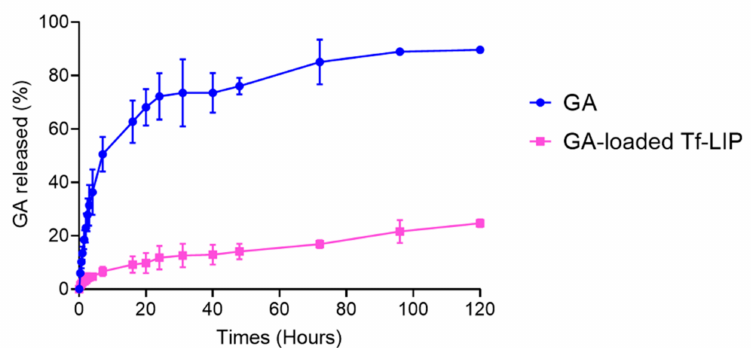
Figure 5. In vitro release profile of GA from Tf-functionalized liposomes (pink data) at 37 ◦ C in PBS (pH 7.4, 10 mM) for 120 h. Blue data shows the in vitro release profile of free